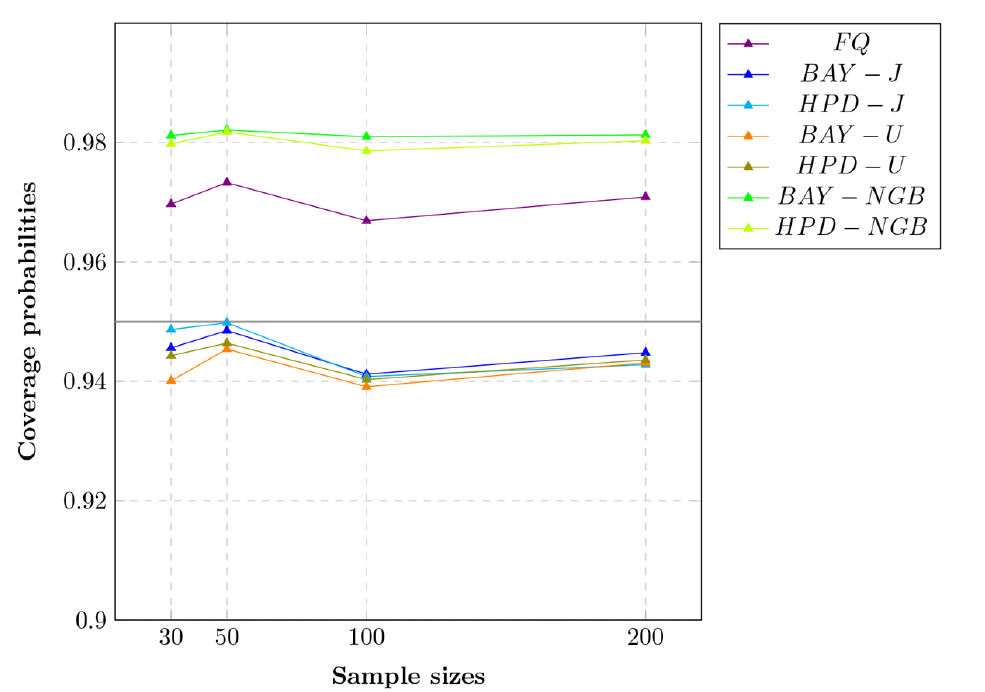
Figure 1. Line graphs of the CPs of the methods in the simulated scenario with different sample sizes.